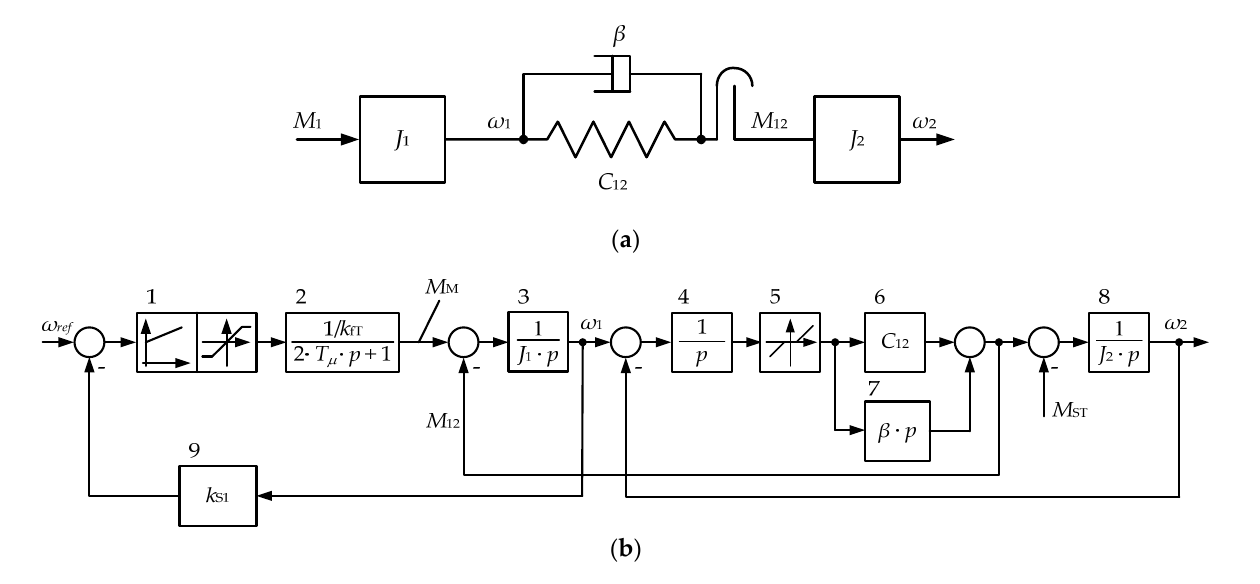
Figure 2. Kinematic diagram of the transmission ( a ) and block diagram of the two-mass electrome-